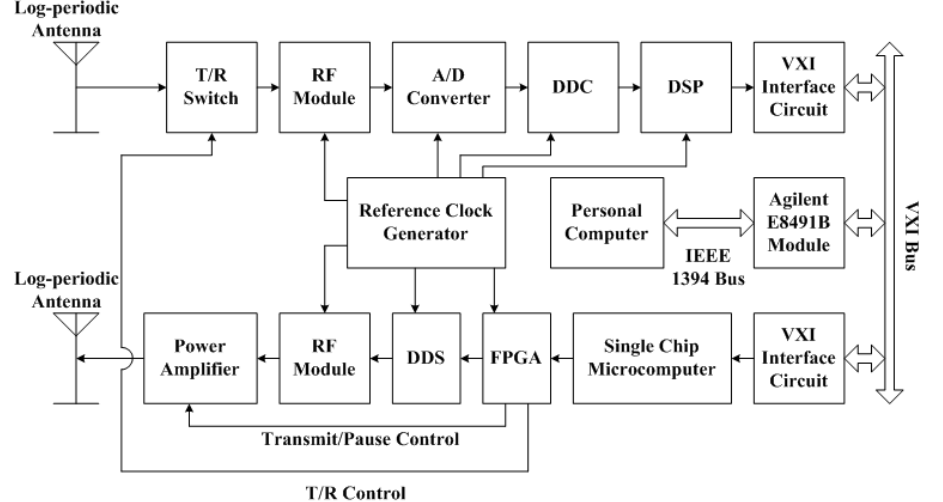
Figure 1. Block diagram of the second version of Wuhan Ionospheric Oblique Backscattering Sounding System (WIOBSS). A/D: analog-to-digital; DDC: digital downconversion; DDS: direct digital synthesizer; DSP: digital signal processor; FPGA: field programmable gate array; T/R: transmit/receive; VXI: Versa module eurocard eXtensions for Instrumentation.